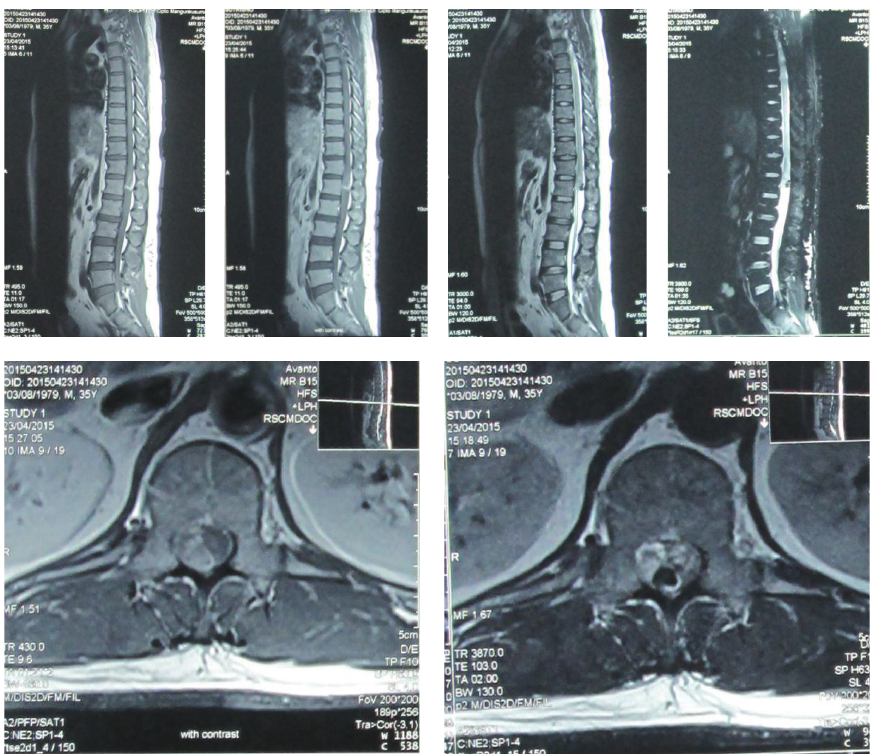
Figure 2: Sagittal and axial view of T1 and T1 with contrast-weighted images showing intradural intramedullary hyperintense signal at L1 level of spinal cord. Sagittal and axial T2-weighted images showing isointense signal of the lesion (taken on 23 June